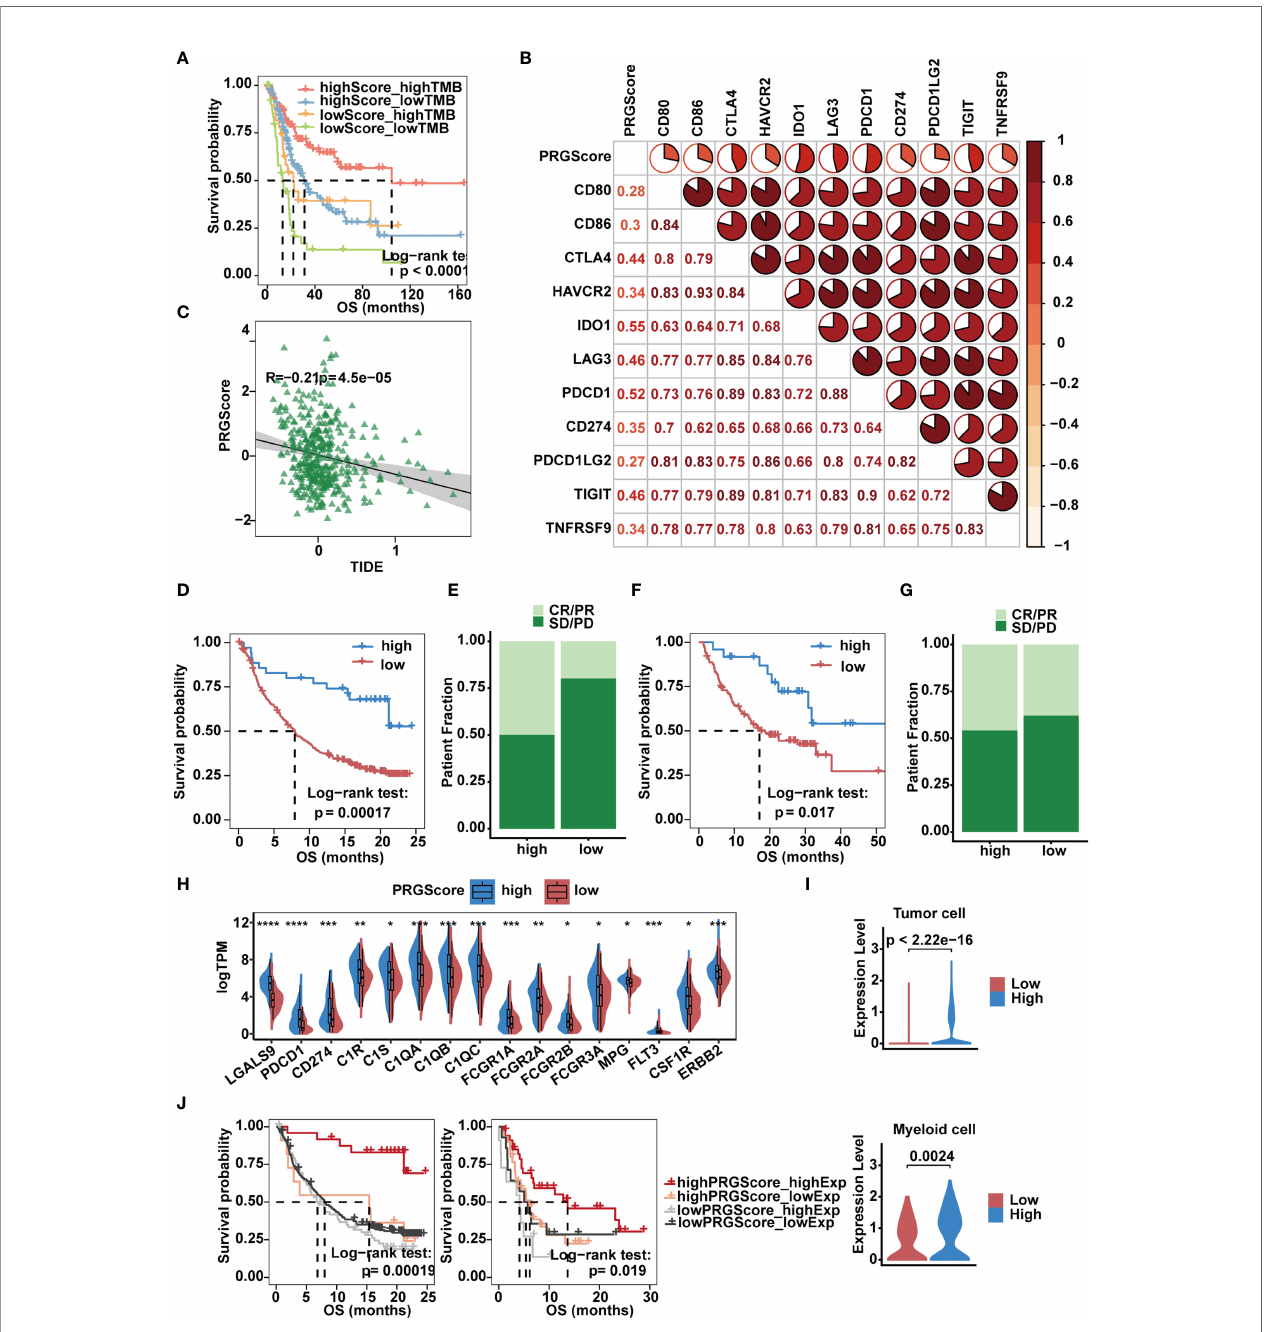
FIGURE 7 | Implication of the PRGScore and its role in the prediction of response to anti-PD-1/L1 immunotherapy. (A) Kaplan-Meier curves showing that PRGScore was signi fi cantly associated with favorable survival outcome in either the high or low TMB subset of the TCGA-MIBC cohort. (B) Correlations between PRGScore and immune checkpoint gene expression in the TCGA-MIBC cohort. (C) Scatter plots showing the signi fi cantly negative correlation between PRGScore and TIDE score in the TCGA-MIBC cohort. The Pearson correlation between PRGScore and TIDE score is shown. (D) Survival analysis for patients with high and low PRGScores in the IMvigor210 cohort. (E) The proportion of patients with or without response to PD-L1 blockade therapy in the PRGScore-high and PRGScore-low groups in the IMvigor210 cohort. (F) Kaplan-Meier curve showing OS for the PRGScore-high and PRGScore-low groups in the melanoma cohort. (G) The proportion of patients who responded to immune checkpoint blockade therapy in the PRGScore-high and PRGScore-low groups in the melanoma cohort. (H) Expression of BLCA-related drug targets in the PRGScore-high and PRGScore-low groups of the TCGA-MIBC cohort. The asterisks represent the statistical P value (*p < 0.05; **p < 0.01; ***p < 0.001; ****p < 0.0001). (I) Expression of LGALS9 in the PRGScore-high and PRGScore-low groups of the tumor cells (top) and myeloid cells (bottom) in the single cell dataset. (J) Kaplan-Meier curves showing that PRGScore was signi fi cantly associated with favorable survival outcome in either the high or low LGALS9 expression subset of the IMvigor210 and GSE176307